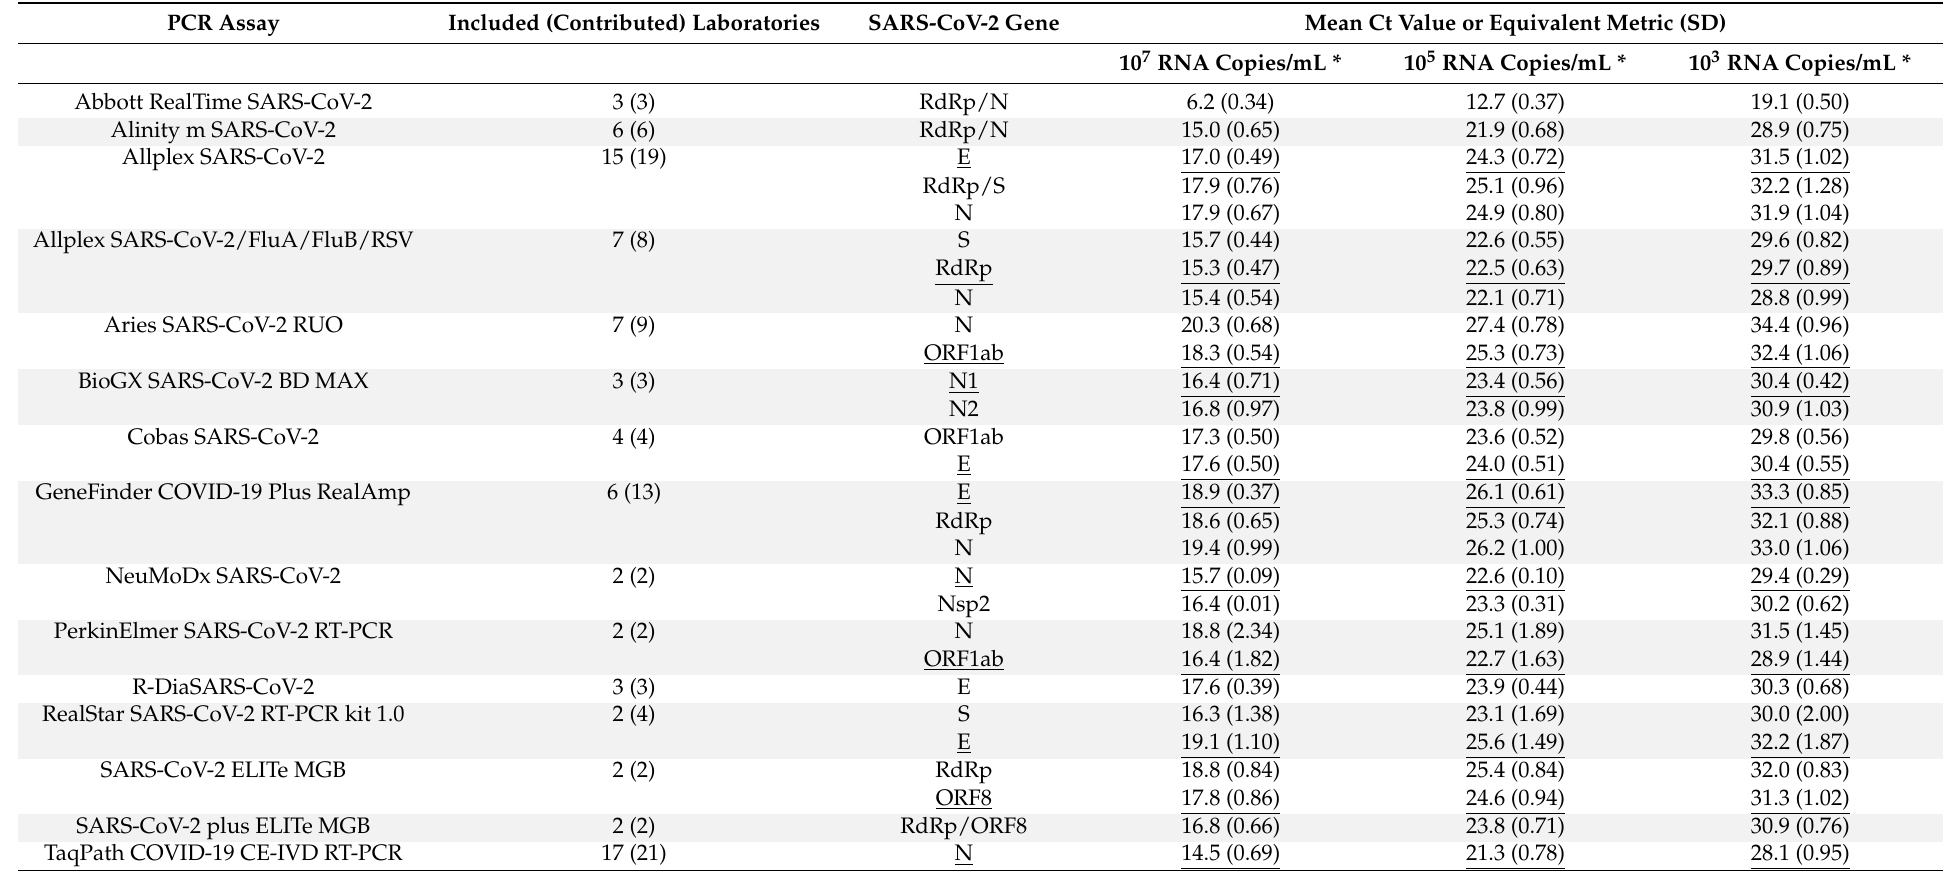
Table 3. Overview of mean cycle threshold (Ct) values with corresponding standard deviation (SD) for the 17 PCR assays that meet the inclusion criteria for downstream analysis, based on the data provided by the laboratories that were included (see Section 2). Mean results should be carefully interpreted, especially when SD values exceed 1 (highlighted in red). The proposed target gene to use for semi-quantitative reporting is underlined in case